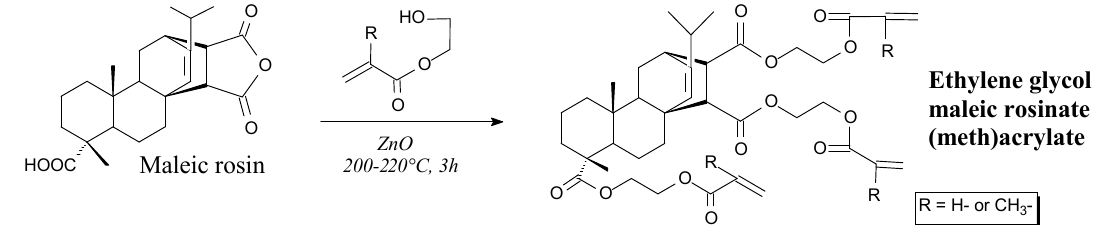
Scheme 16. Preparation of ethylene glycol maleic rosinate acrylate.